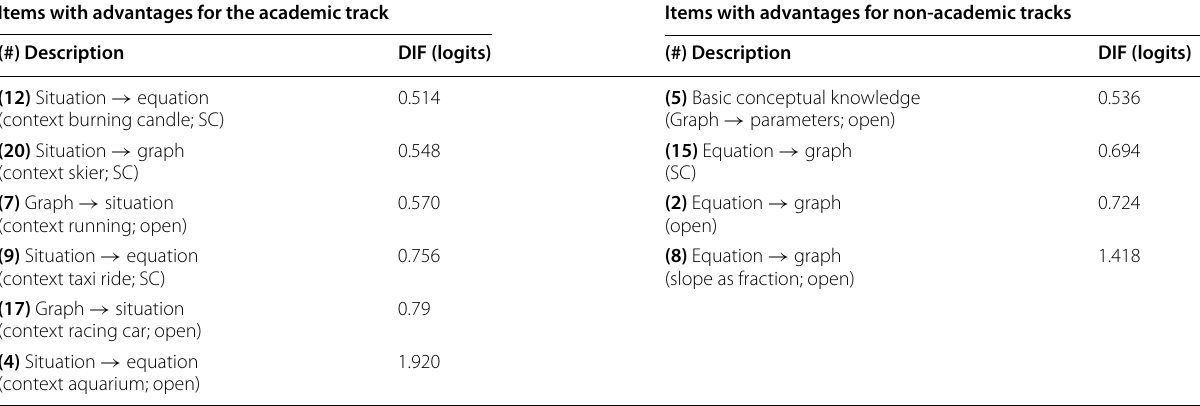
The information given in brackets provides details on the corresponding test items SC single-choice format, open open-ended format